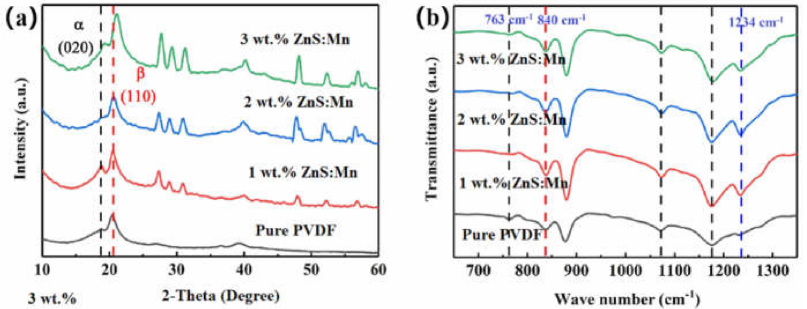
Figure 5. PVDF composite thin films with different mass percentages of ZnS:Mn: ( a ) XRD patterns; ( b ) FT-IR